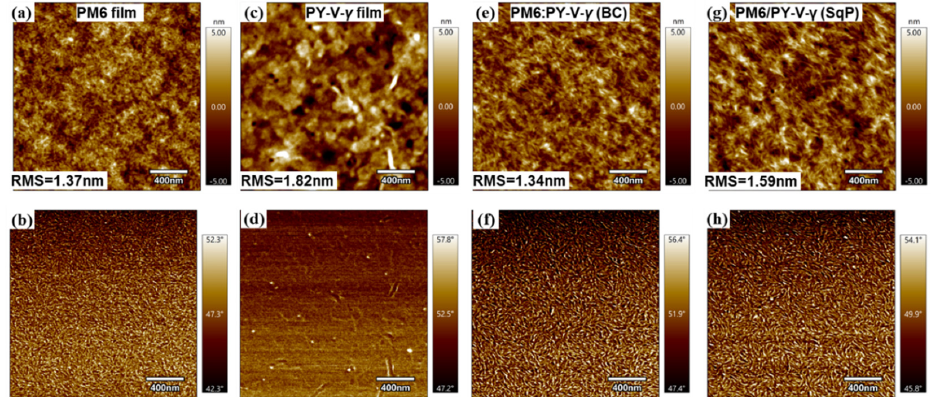
Figure 6. AFM height (top) and phase images (bottom) of ( a , b ) PM6 film, ( c , d ) PY-V- γ film, ( e , f ) PM6:PY-V- γ (BC), ( g , h ) PM6/PY-V- γ (SqP).